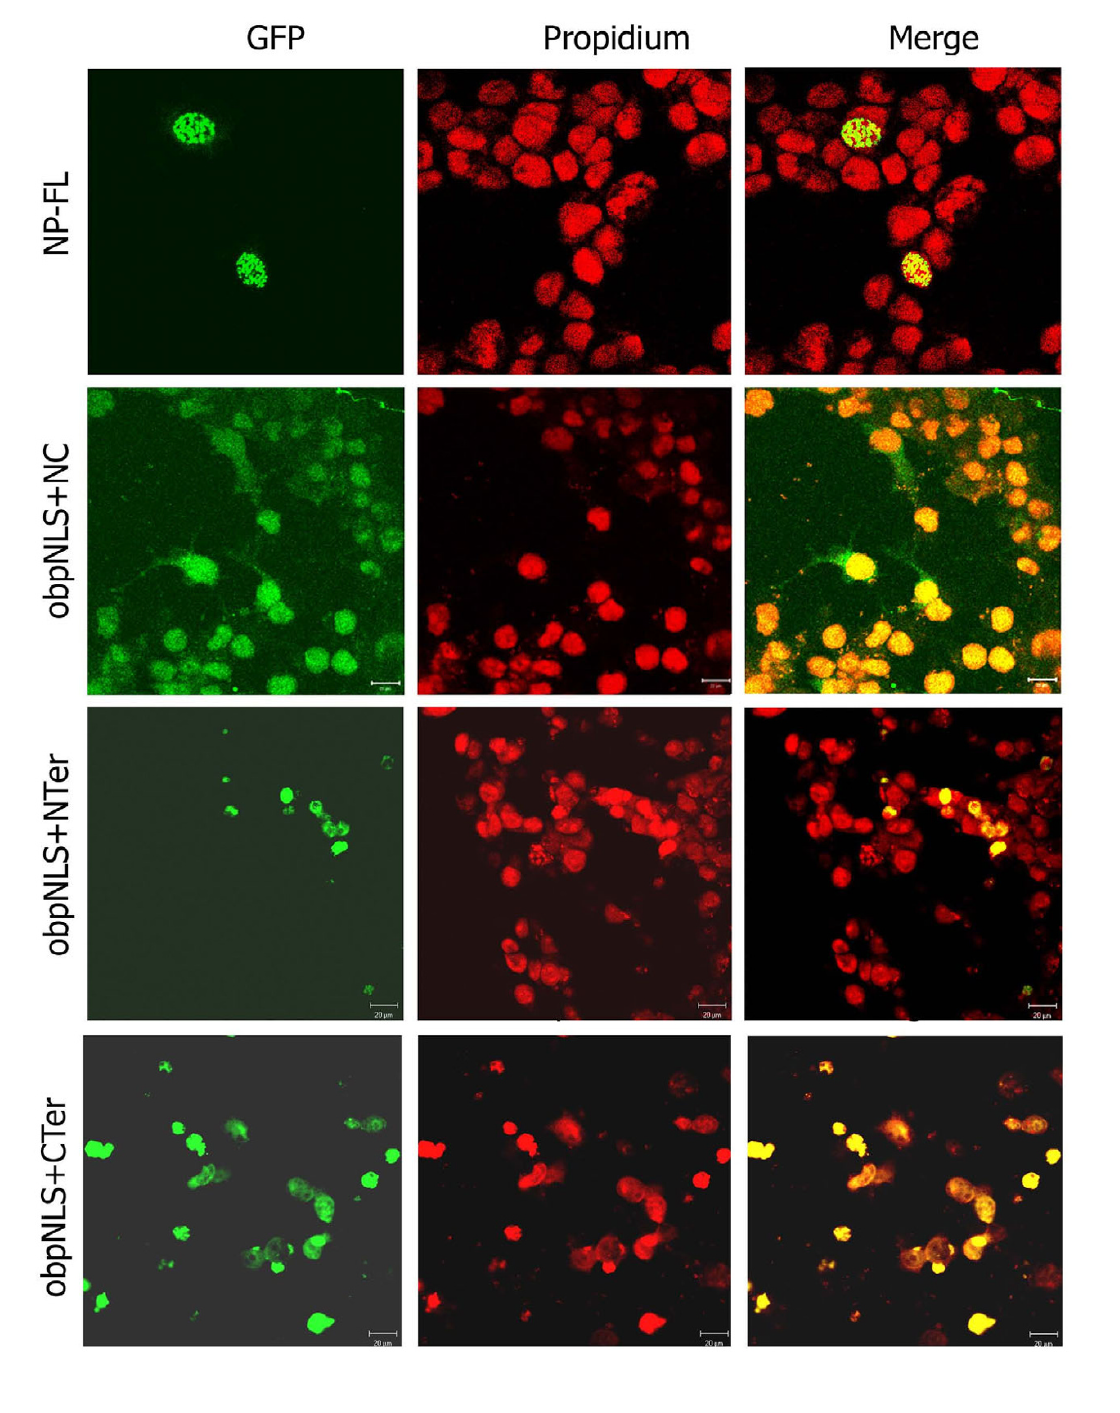
Figure 5 Confocal immunofluorescence analysis of various NP constructs containing the obpNLS. COS-7L cells transfected with the various NP-GFP constructs were fixed and mounted with propidium iodide-containing medium to indicate nuclear staining. NP-L exhibits a typical punctuate, nuclear localization pattern. obpNLS+NC, obpNLS+N-ter and obpNLS+C-ter all localize to the